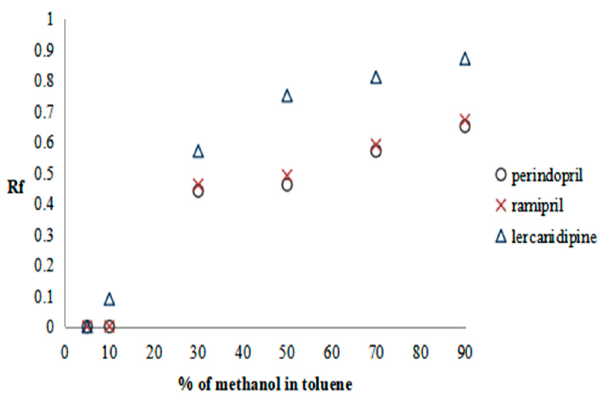
Figure 1. Plots of substance retention relationships vs. the mobile phase composition for the first group of drugs. Stationary phases: HPTLC silica gel 60 F 254 .